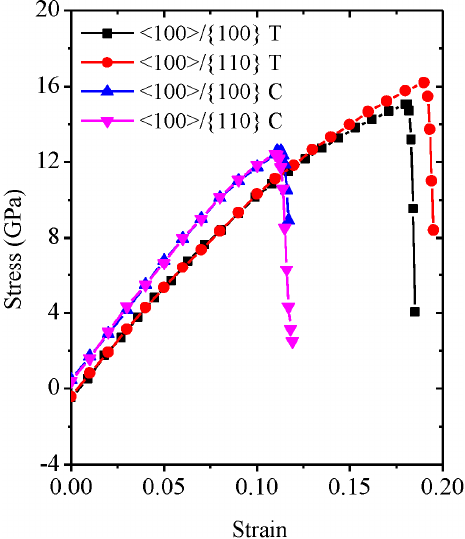
Figure 2. Stress – strain curves of the silicon nanowire with a width of 7.7 nm. The character “T” and “C” designate “tension” and “compression”, respectively. Both compressive stress and strain are taken as positive value.